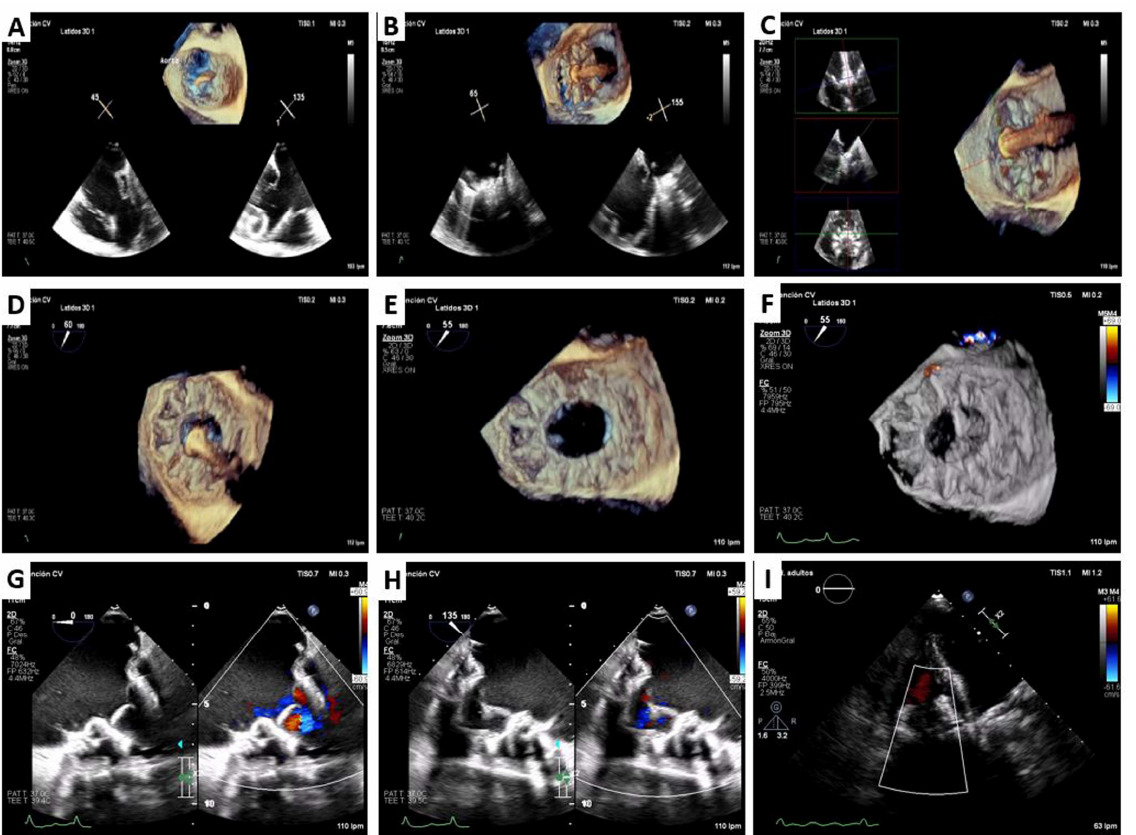
Figure 4. Cardiovalve TTVR case. Transesophageal echocardiography procedural monitoring. A pigtail catheter was used to advance a high support guidewire to right ventricular apex ( A ). Once the system was above the valve, the leaflet grasping legs were opened in the left atrium ( B ). The whole system was centered and advanced into the right ventricle in order to grasp the native leaflets, which was assured with live 3D-MPR ( C ). Then, atrial flange was released ( D ) and the delivery system was retrieved ( E , F ). The absence of tricuspid regurgitation may be checked on transesophageal ( G , H ) and transthoracic echocardiography ( I